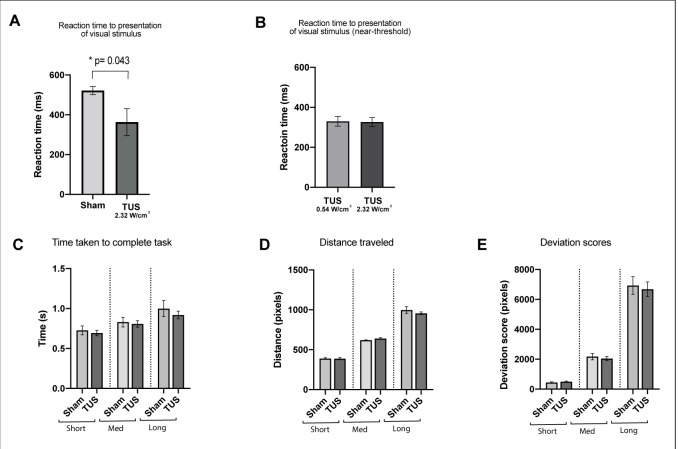
Results of the visuo-motor behavioral task experiment, showing reduction in a pooled reaction time to the presentation of visual stimulus with TUS at 2.32 W/cm2, p=0.043, paired t-test (N = 12).Reaction times for TUS at 2.32 W/cm2 compared to 0.54 W/cm2 were not significantly different (N = 4). Bottom row: Comparison of Sham and TUS trials sorted by distance to target (near, medium, far). N = 12. Asterisk denotes significance p<0.05 on paired t-test. Error bars represent standard error.